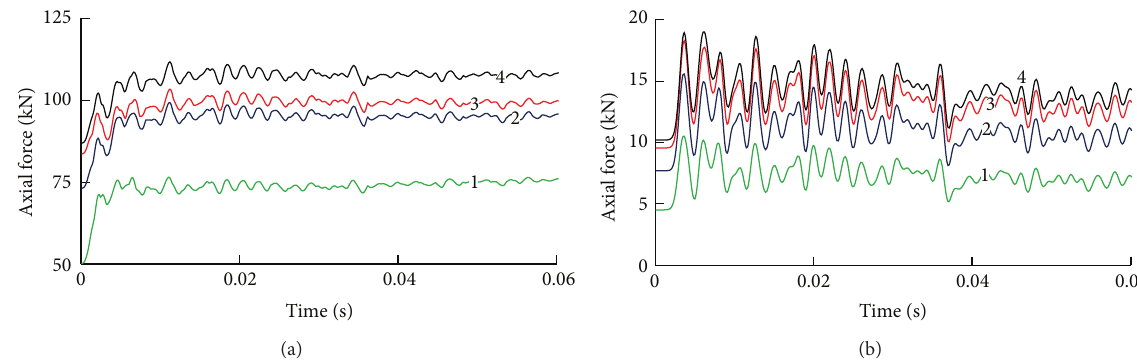
Figure 5: Evolution of axial forces of the first row of bolts in the roof; (a) free segment and (b) anchoring segment.